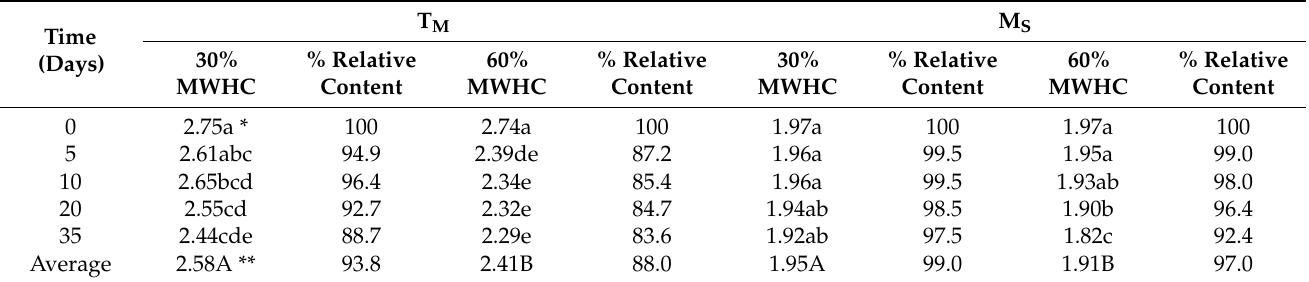
Table 6. Effect of incubation time and soil moisture on the release rate of organic nitrogen from organic fertilizers.